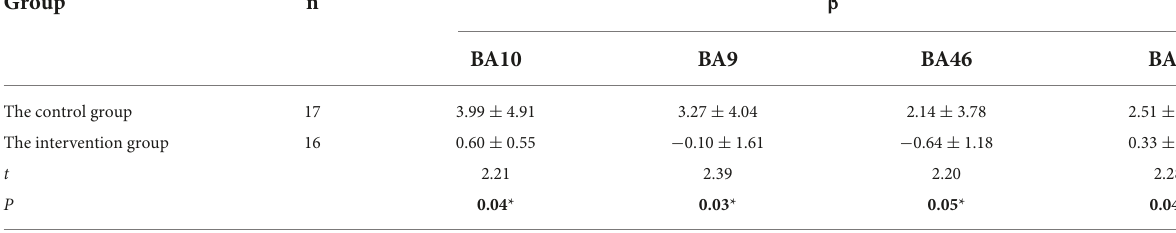
TABLE 5 Comparison of the activation intensity of ROI brain regions between two groups of patients.